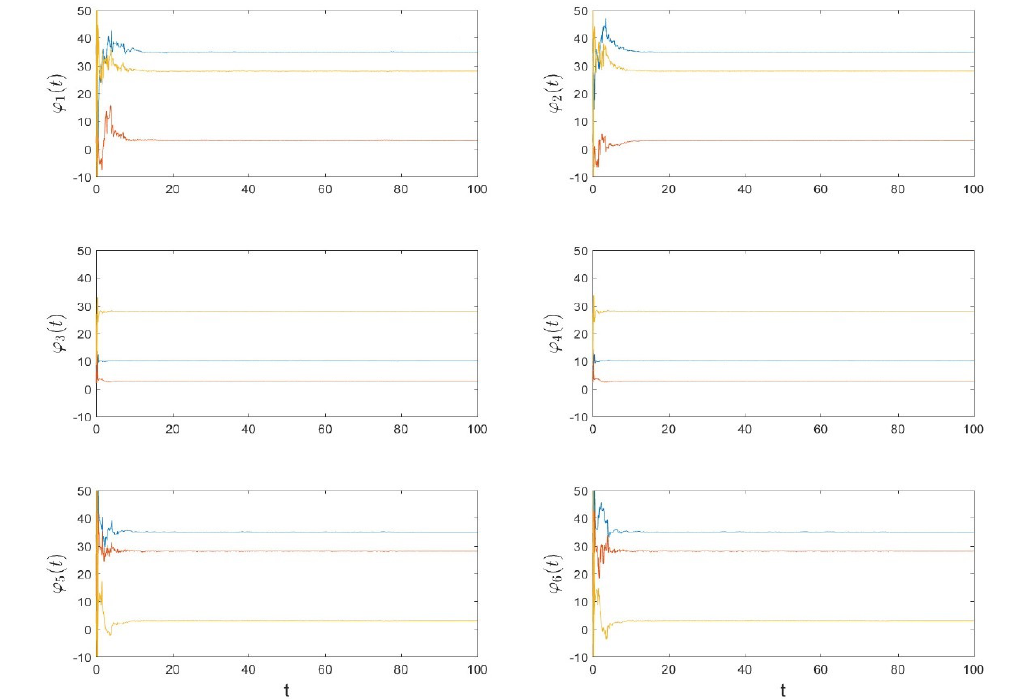
Figure 4. (Color online) The blue, red and yellow lines denote the first, second and third components of the state variables ϕ i ( t ) respectively.